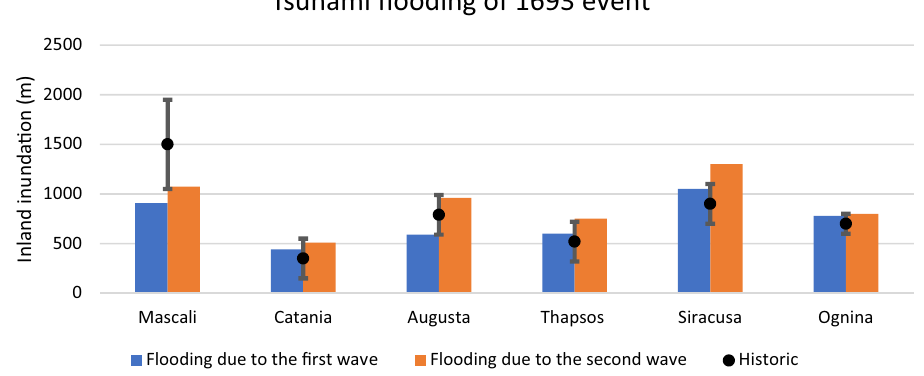
Figure 8. Inland inundation modelled for the coastal areas of Mascali, Catania, Augusta, Priolo-Thapsos Peninsula, Siracusa, Ognina (see Fig. 3 for location): flooding due to the first wave impact is marked with blue histogram; flooding due to the second wave impact is marked with red